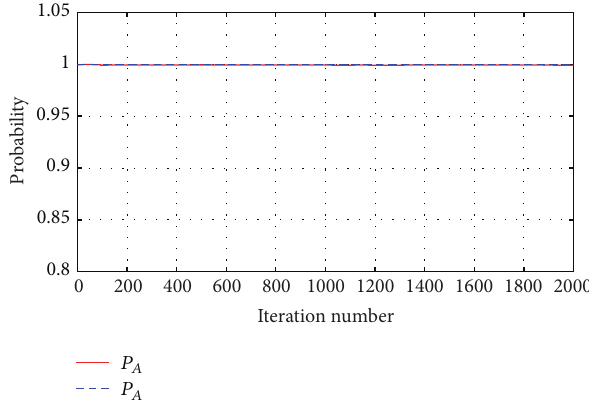
Figure 5: Comparison of two probabilities with ACO.